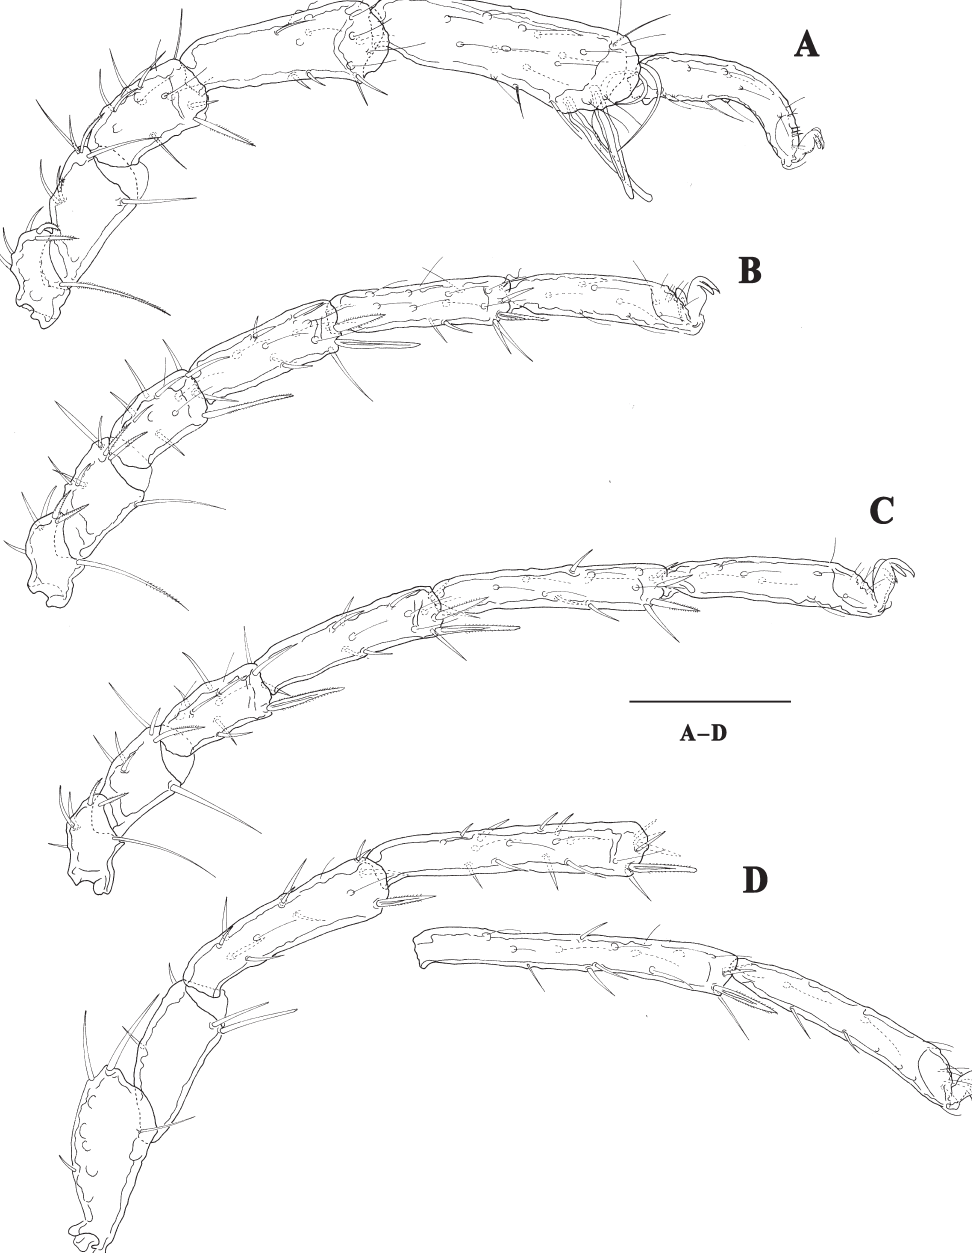
Fig. 3. Atractides ( Atractides ) biprojectus Zhang, Li & Guo sp. nov., holotype, ♂ (GUGC, Slide